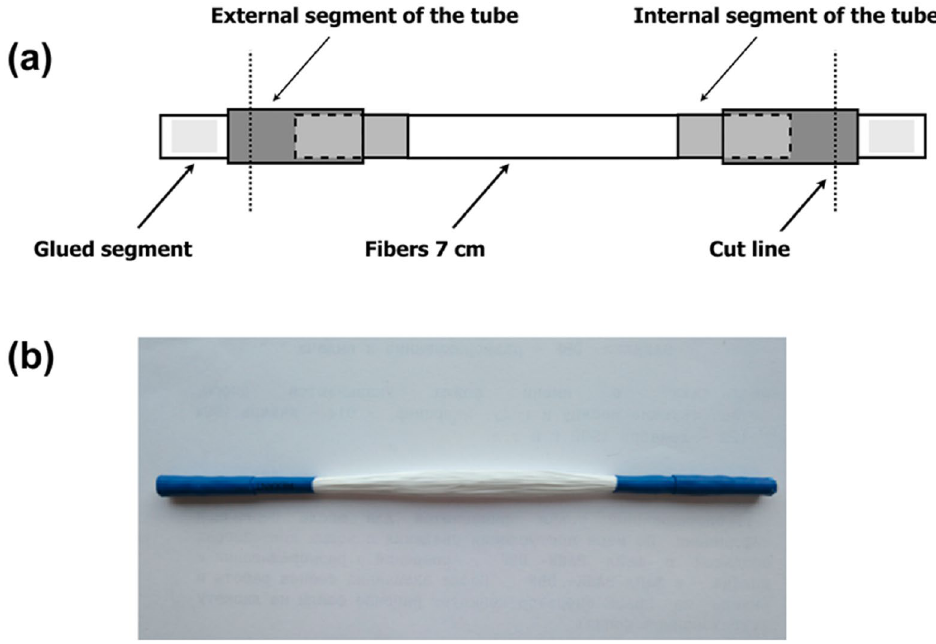
Figure 7. Scheme ( a ) and photo ( b ) of a small-volume